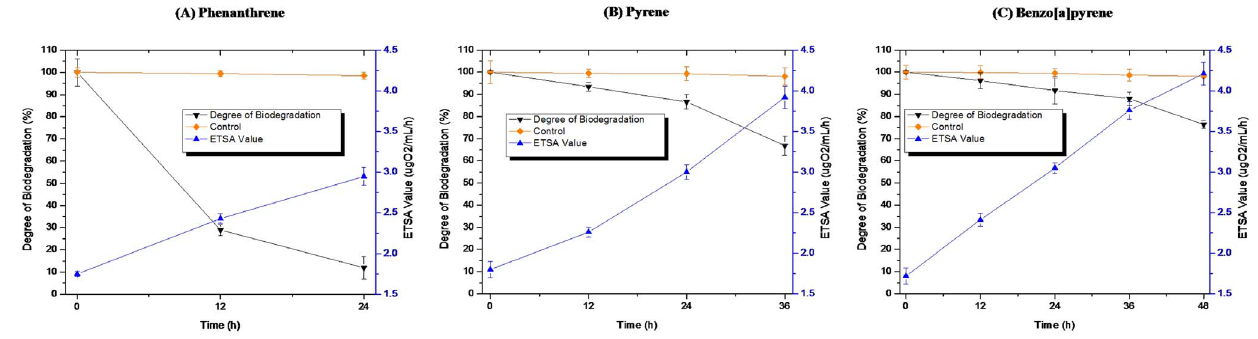
Figure 1. ETSA values and biodegradation rate of phenanthrene (A), pyrene (B), and benzo[a]pyrene (C) by Novosphingobium pentaromativorans US6-1 (mean and standard deviation of triplicate samples are shown.).